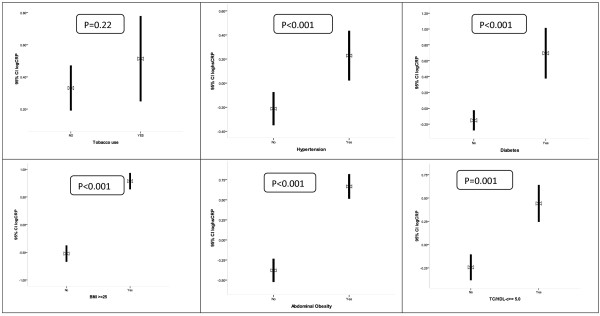
Association between CRP and risk factors of CVD (error bars). BMI, body mass index; TC/HDL-c, Total cholesterol/High density lipoprotein cholesterol, hsCRP, high sensitivity C-reactive protein; hsCRP, high sensitivity C-reactive protein